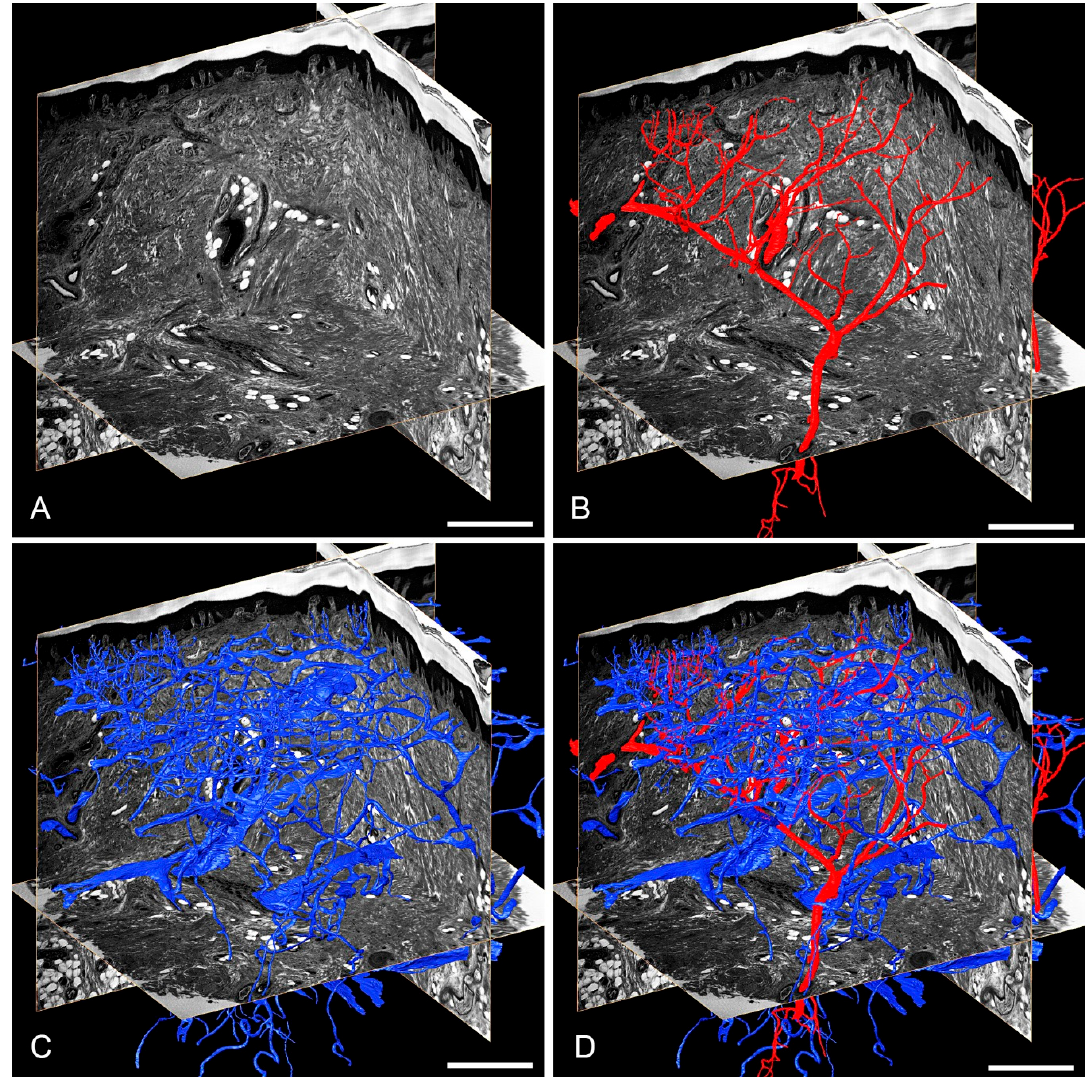
Figure 2. Thick skin of human thumb pad. Virtual sections through HREM data ( A ) together with surface models of dermal arteries ( B ), dermal veins ( C ) and both ( D ). Scalebars: 500 µm.